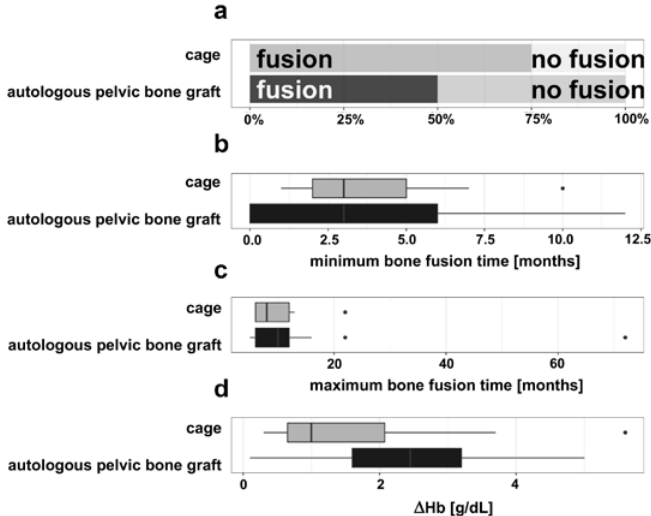
Figure 2. ( a ) Bony fusion of cage implantation ( n = 12) and autologous pelvic bone graft ( n = 34). p = 0.0216. ( b ) Minimum bone fusion time. Shown data as median values with minimum and maximum. The isolated point represents a data outlier. ( c ) Maximum bone fusion time. Shown data as median values with minimum and maximum. The isolated points represent data outliers. ( d ) Average Hb decrease ( Δ Hb) between an average preoperative value and an average postoperatively value of the cage implantation collective ( n = 12) and the autologous pelvic bone graft collective ( n = 34). Shown data as median values with minimum and maximum. The isolated point represents a data outlier.